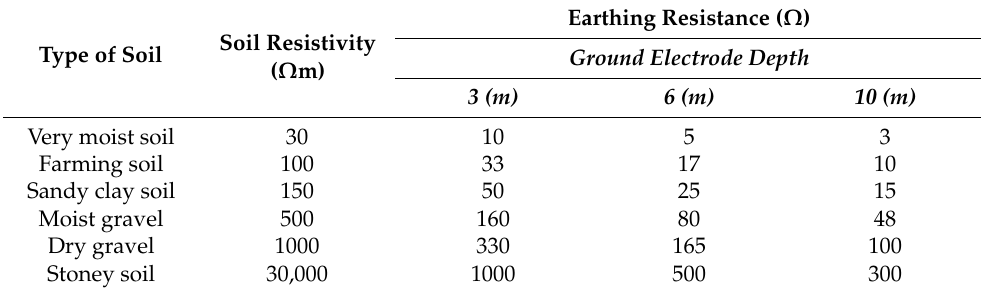
Table 4. Soil resistivity and earthing resistance of different soils [19].